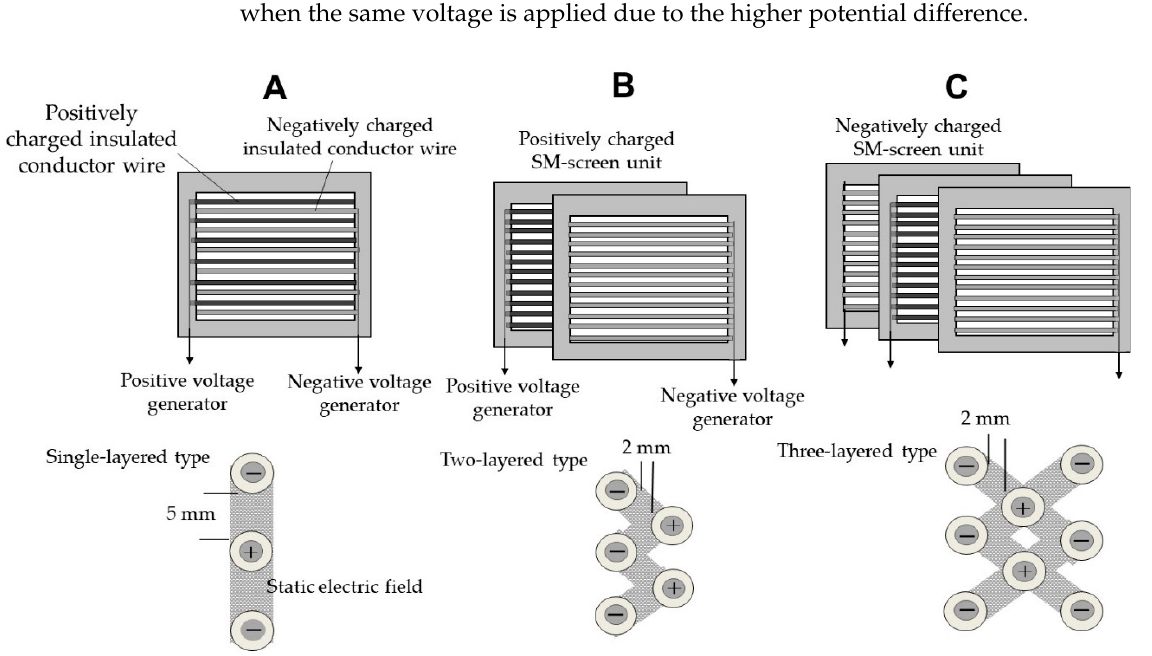
Figure 4. Three types of DD screens for capturing insect pests and the static electric fields formed by the DD screens. ( A ) A unit of the single-layered DD screen, where oppositely charged insulated conductor wires are arrayed alternately. ( B , C ) Two- and three-layered DD screens. Two or three oppositely charged SM screen units were combined in an offset arrangement with the oppositely charged insulated conductor wires.